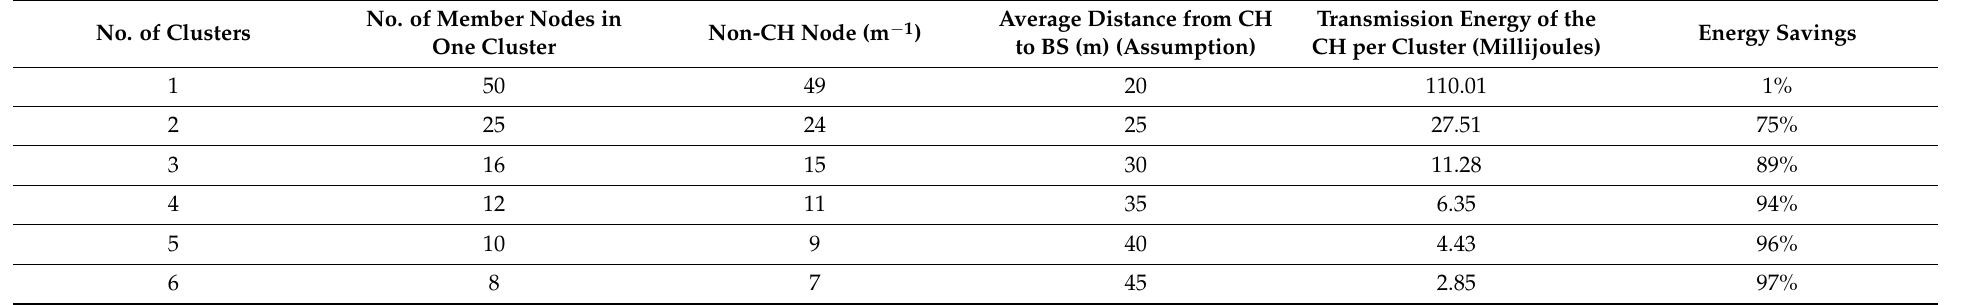
Table 8. Energy calculations for inter-cluster